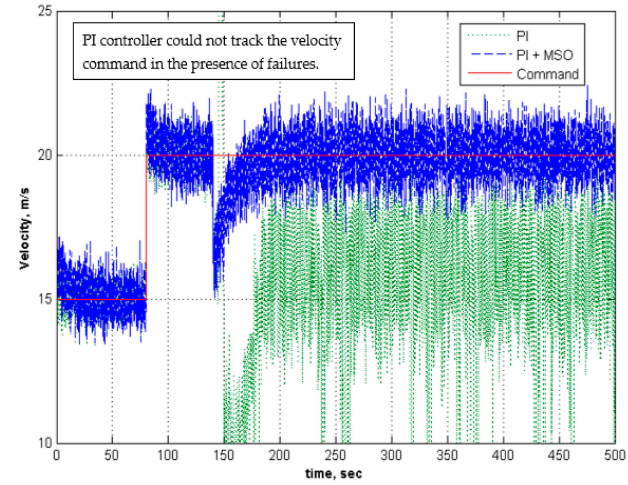
Figure 16. Velocity response for 50% C m α in an